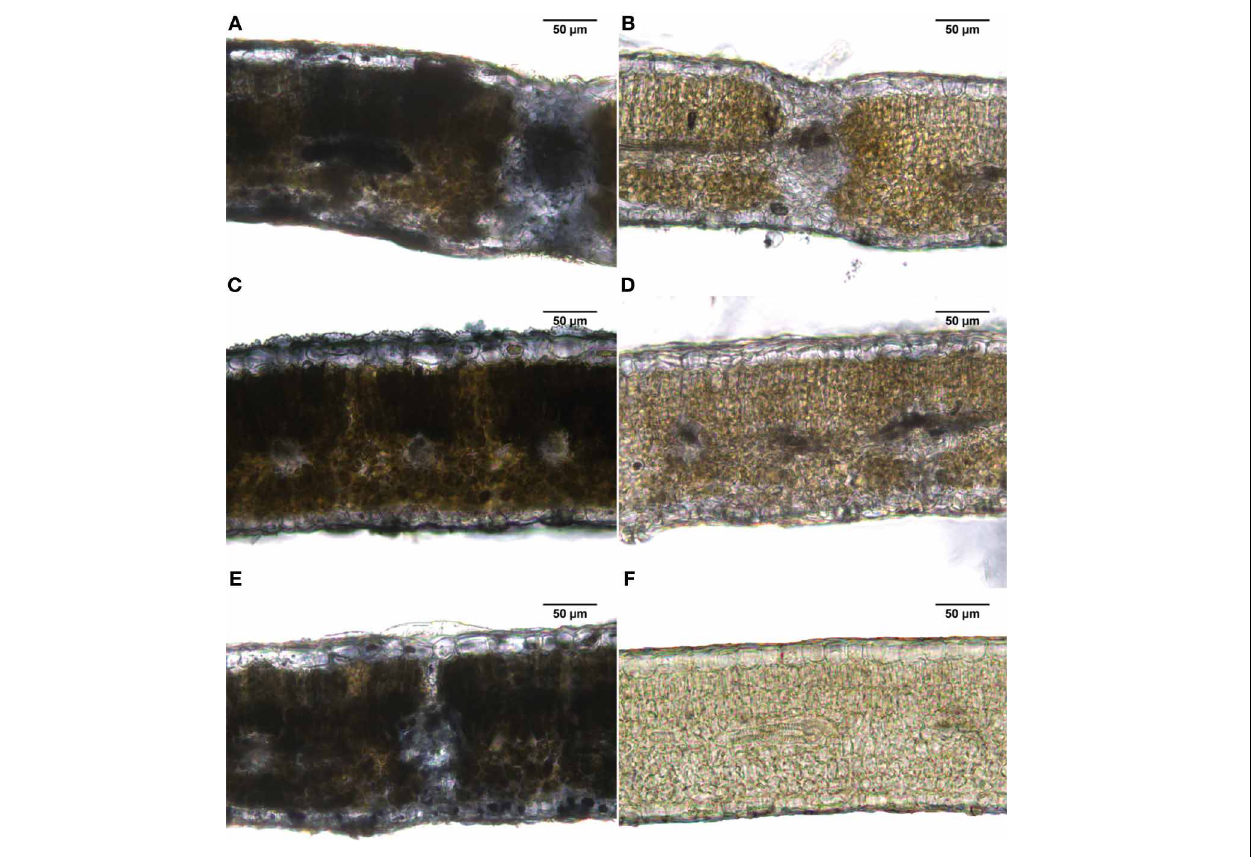
untreated leaf part in the same leaves used for (C) ; (E) leaves of a soil Fe-fertilized tree (Fe(III)-EDDHA -Sequestrene-, 50g per tree); and (F) negative